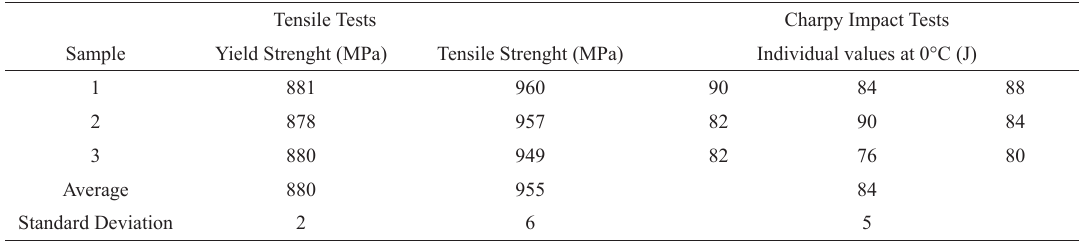
Figure 5: Geometrical modifications used in the parametric study. Table 5: Mechanical properties of API 5CT grade P110